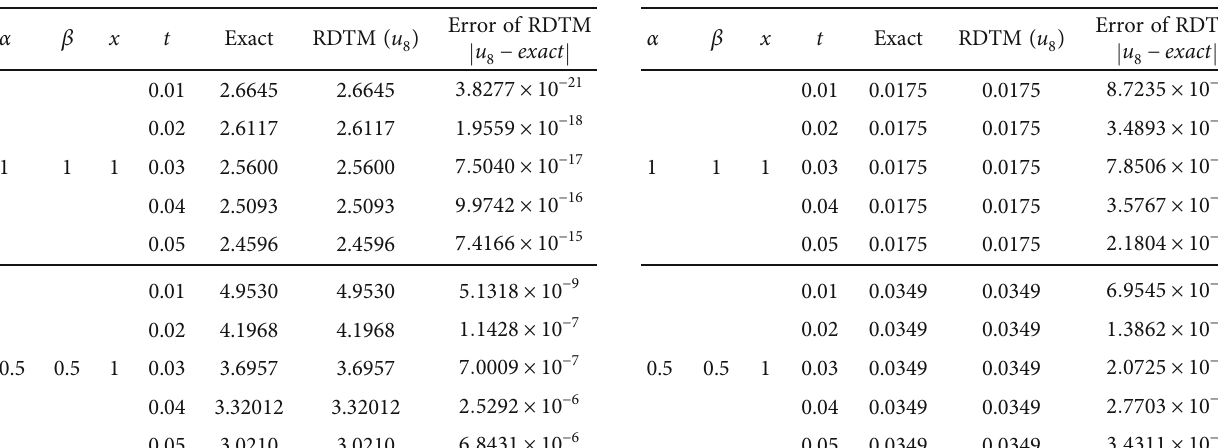
Table 2: Eighth-order approximate solution by RDTM of Example 2 for di ff erent values of α , β , and t and comparison with the exact solution.